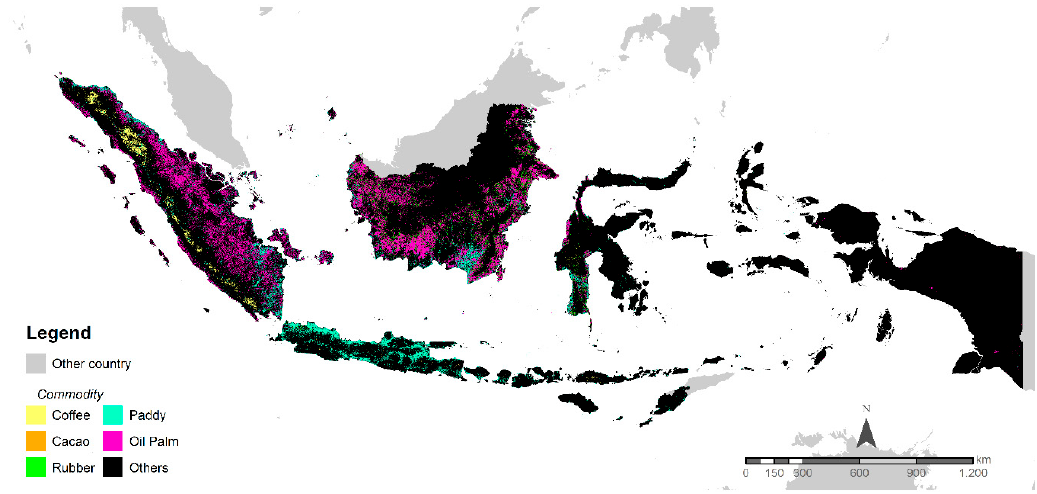
Figure 6. National commodity maps of 2019 using the best RF algorithm (N = 100).